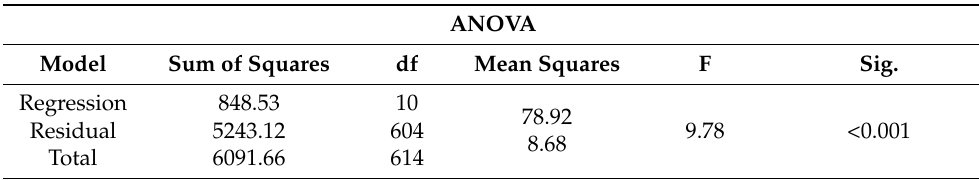
Table 6. Results of the multiple linear regression model predicting feline abnormal repetitive behav- iors (ARBs) as a function of cat, guardian and household